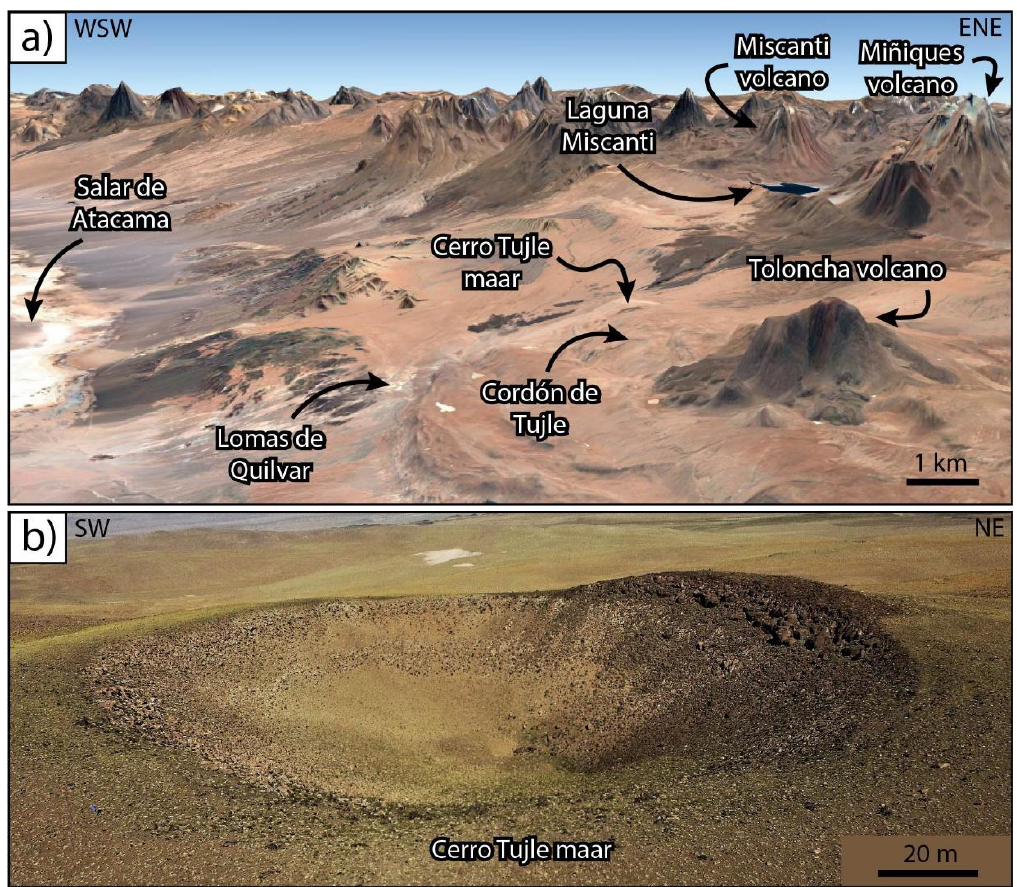
Figure 4. Cerro Tujle maar. ( a ) Satellite image taken from Google Earth TM , showing the location of the Salar de Atacama basin, Laguna Miscanti, and the morphology of the surface. ( b ) Aerial view of the Cerro Tujle maar where it is possible to see the andesitic lava unit under the tephra ring.